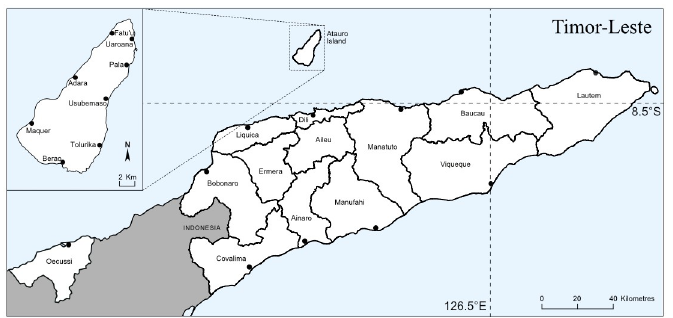
Fig 3. Map of Timor-Leste illustrating landing sites where small-scale fisheries catch was recorded using smartphones or tablets.